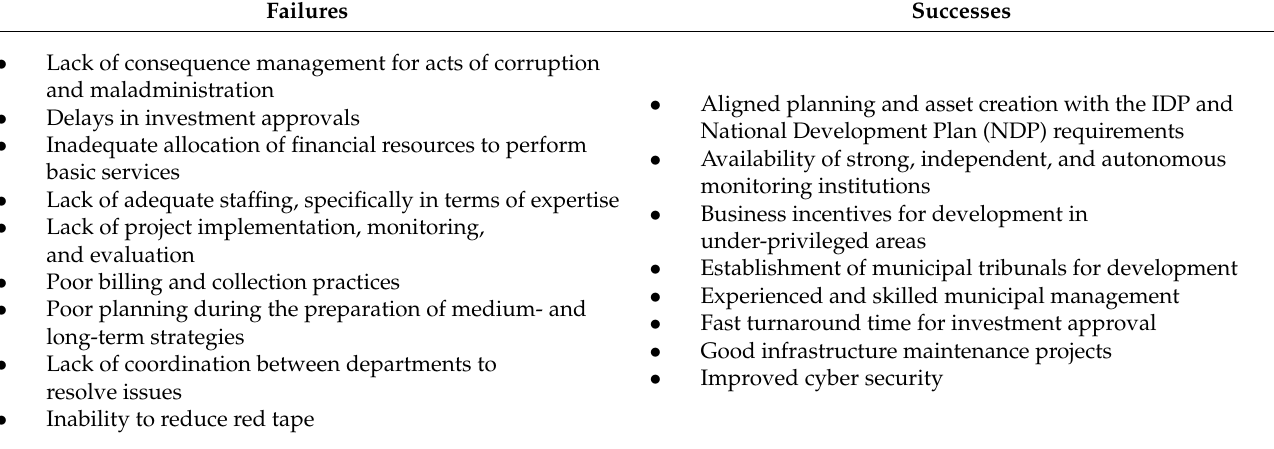
Table 3. Failures and successes in terms of municipal business support.